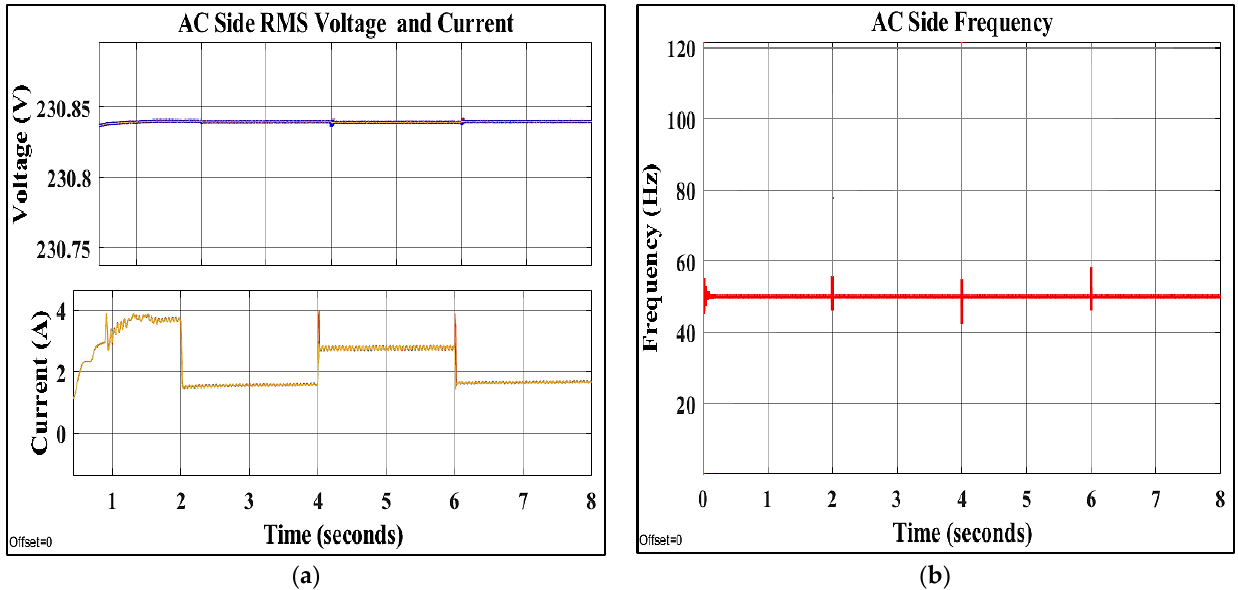
Figure 14. Three-phase AC bus current and voltage.